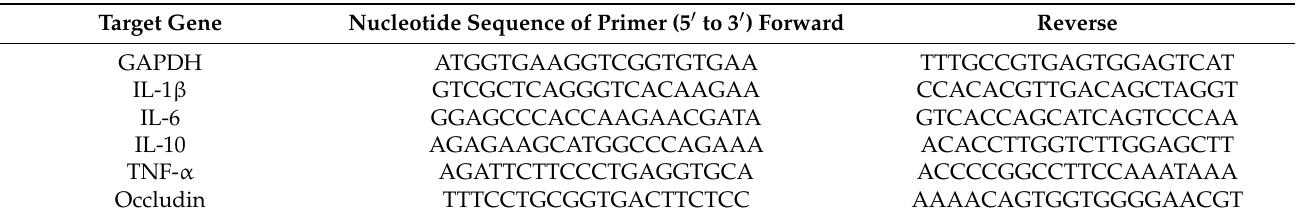
Table 1. Sequences of primers used for quantitative real-time PCR